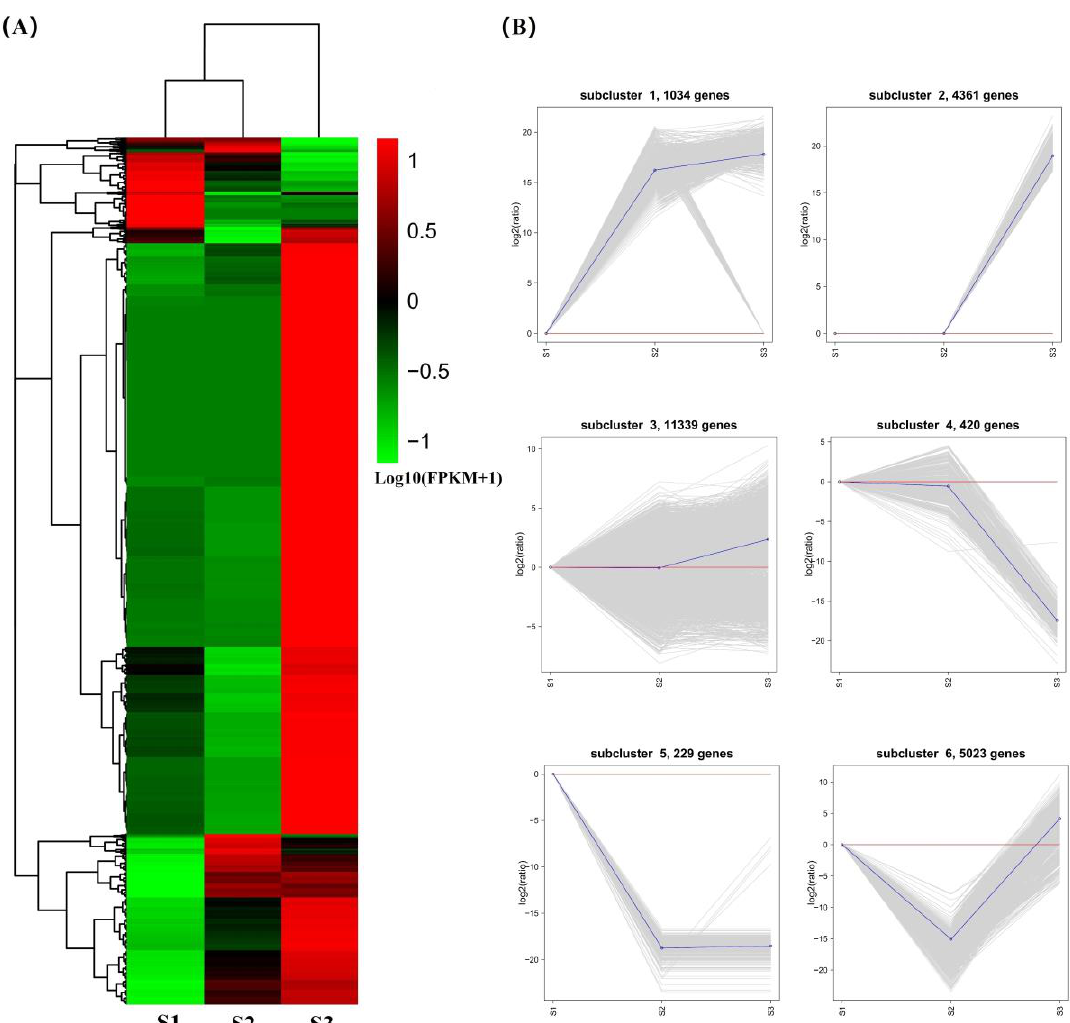
Figure 3. Cluster analysis of DEGs. ( A ) Cluster analysis of DEGs in heat map. The color represents the transcriptional abundance of the DEGs. Red and green represent high and low expression levels, respectively. ( B ) Cluster analysis of DEGs in K-means. The gray line represents the expression pattern of genes in each cluster, and the blue line represents the average expression of all genes in the cluster. FPKM (fragments per kilobase per million) values were log10 (FPKM + 1)-based in ( A ) and FPKM values were log2-based in ( B ).